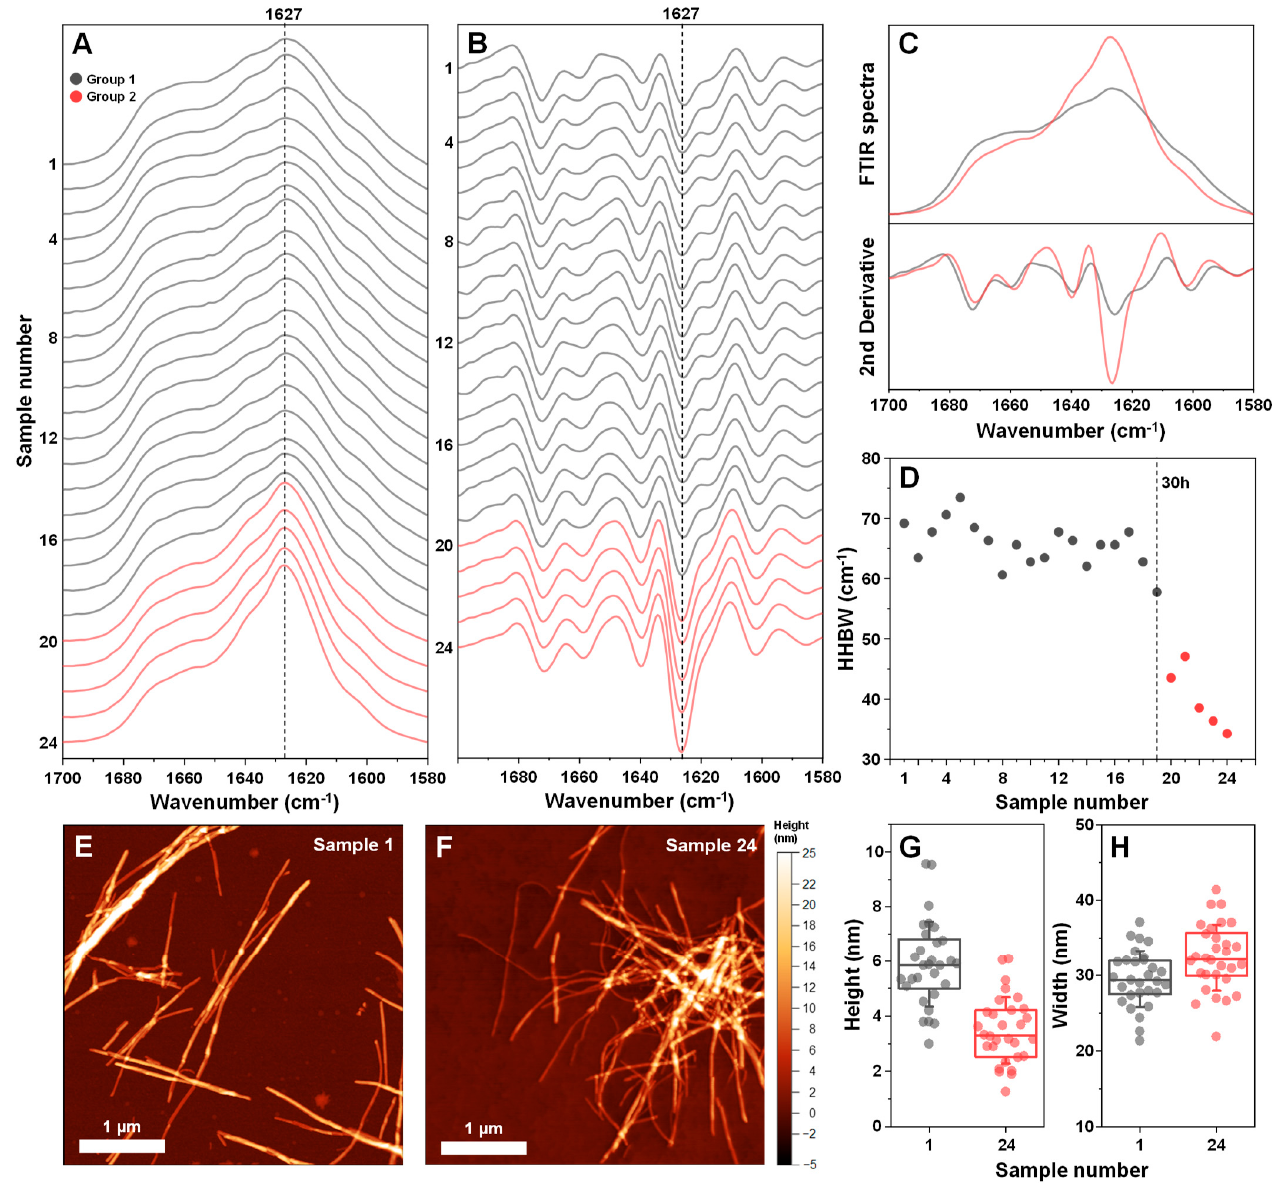
Figure 4. Fourier-transform infrared (FTIR) spectra and atomic force microscopy (AFM) images of insulin fibrils, generated using different incubation time EGCG samples. Twenty-four different insulin fibril FTIR spectra ( A ) and their second derivatives ( B ), prepared using a range of different incubation time EGCG samples. Samples are divided into two groups (group 1–grey color, group 2–red color) based on differences in their FTIR spectra. Comparison of both group FTIR spectra and their second derivatives ( C ). Half-height bandwidth (HHBW) of all 24 FTIR spectra ( D ). AFM images of sample 1 ( E ) and sample 24 ( F ) insulin fibrils and their respective cross-sectional height ( G ) and width ( H ) distribution (n = 30). FTIR spectra and AFM image acquisition is described in the Section 2. Materials and Methods section. Different group spectra and data points are color-coded in all sub- figures.